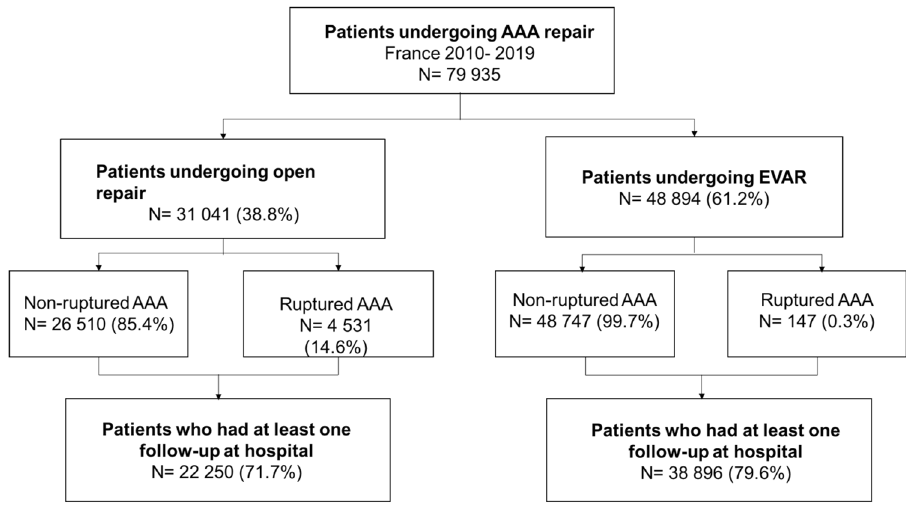
Figure 1. Flow chart of the study population. Data are expressed as n (%).